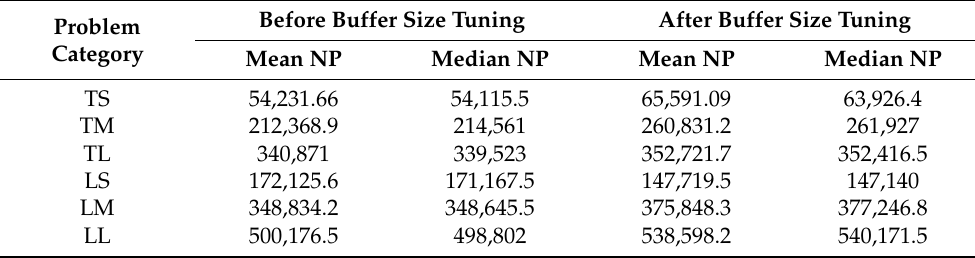
Table 5. Mean and median NP value of each category of problems for before and after buffer size